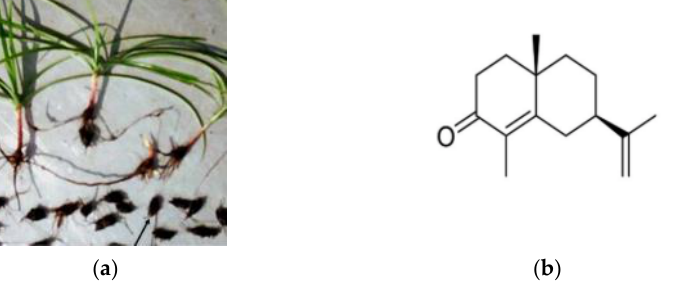
Figure 1. Cyperus rotundus plants and rhizomes (arrow) ( a ) collected in Southern India and the chemical structure of α-Cyperone ( b ) (from Peerzada et al. 2015; Huang et al. 2020). The molecular weight of α-Cyperone is 218.33 Da.